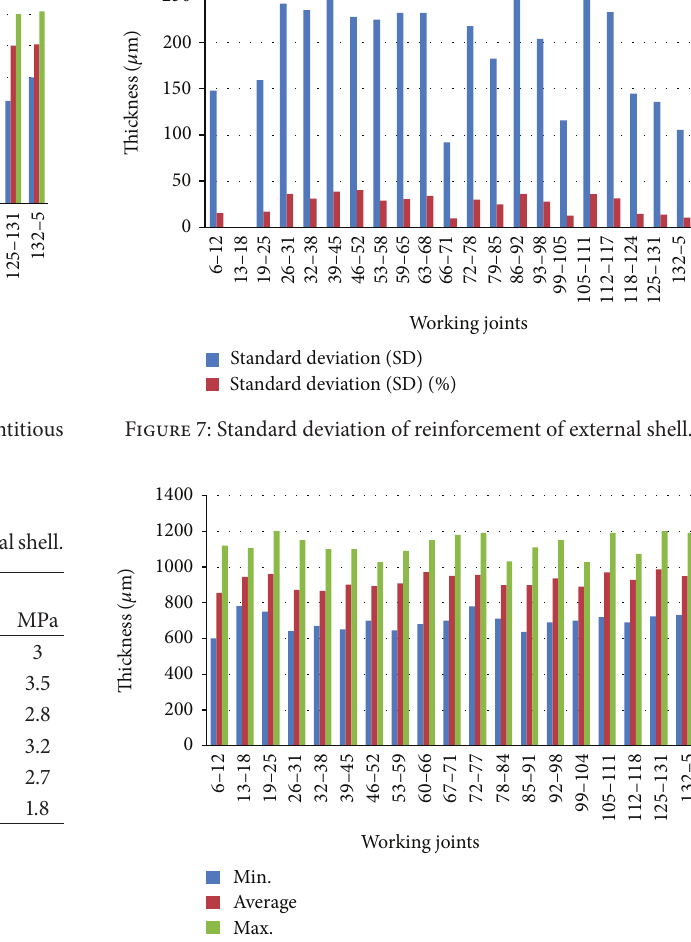
Figure 8: Thickness protection coating of reinforcements ( 𝜇 m) for internal